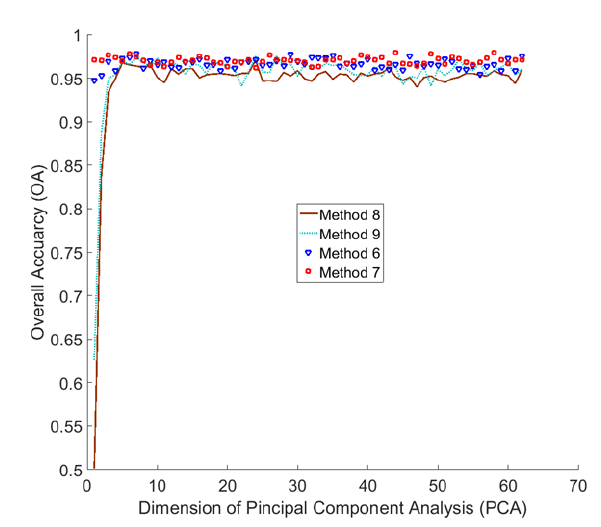
Figure 6. Dimension of PCA and Overall Accuracy (OA) obtained by decision tree.